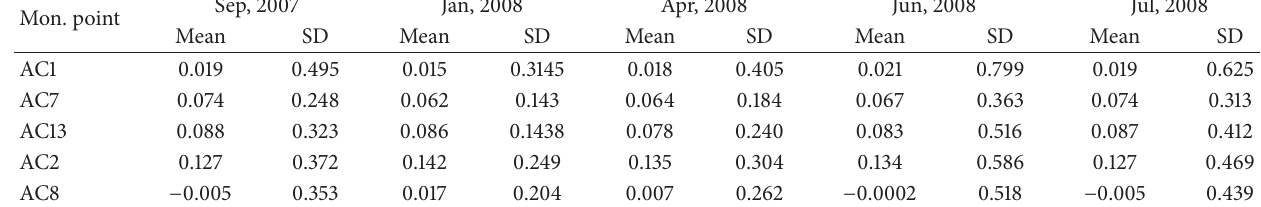
Table 1: Mean and standard deviation of monitoring selection points (cm/sec 2 ). Mon. point